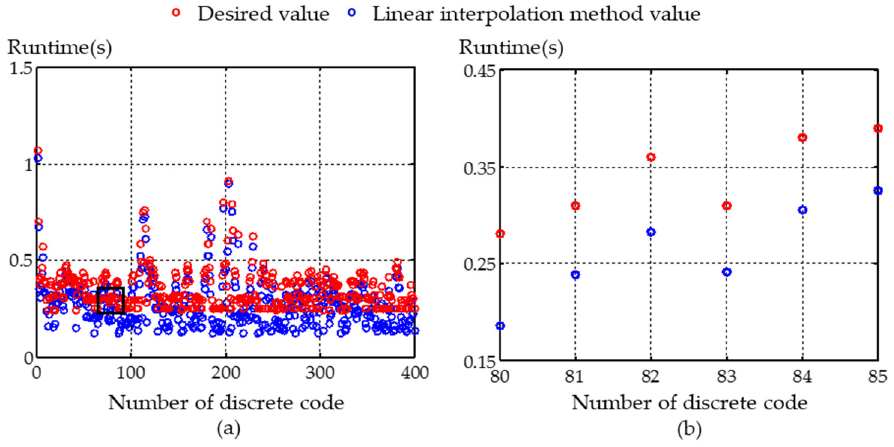
Figure 7. Runtime of the trajectory interpolated by the linear method: ( a ) runtime of the trajectory; and ( b ) the partial enlarged view.